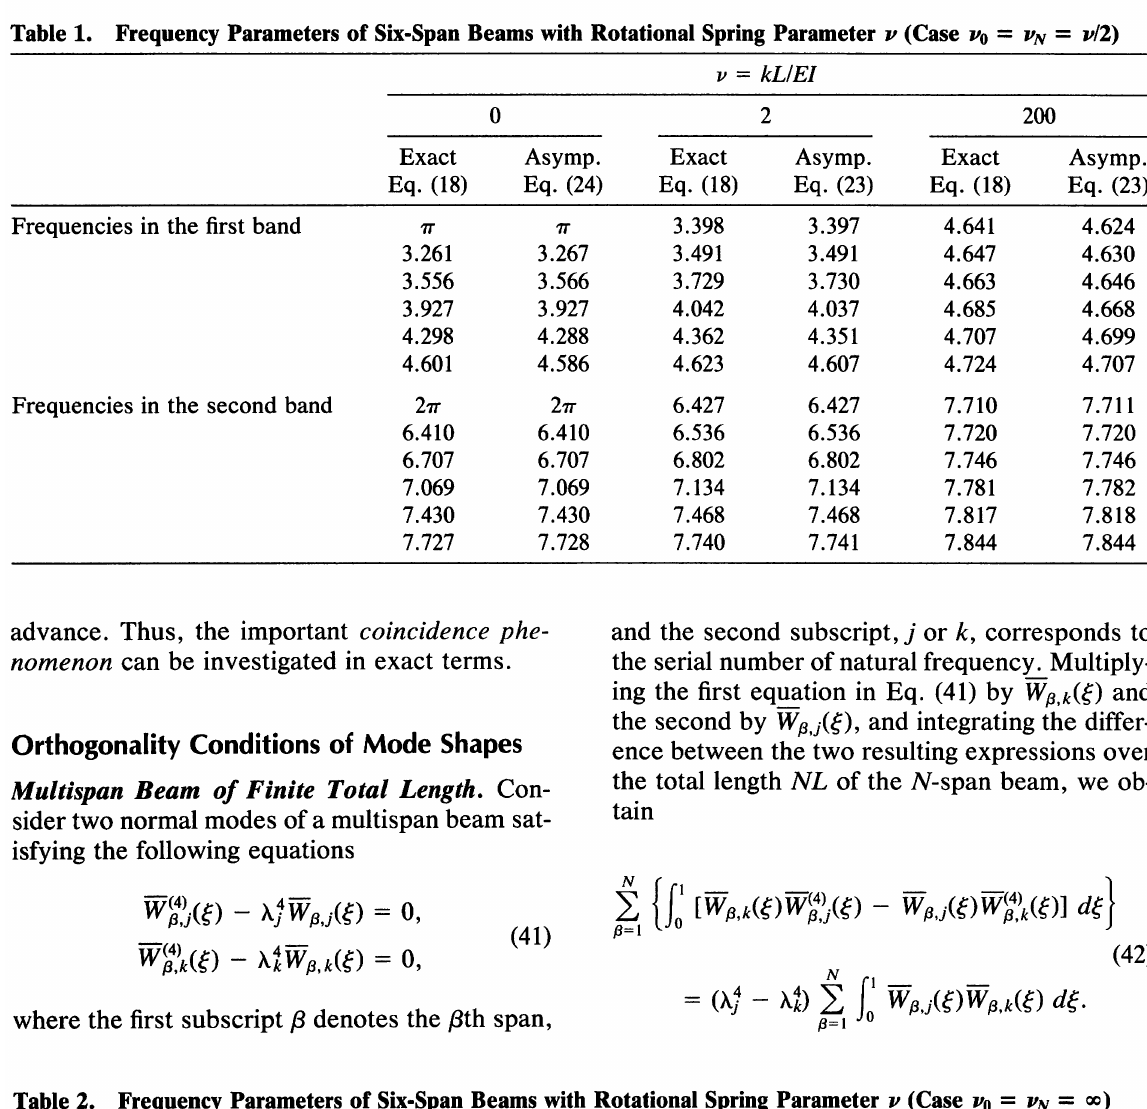
= = 00) VN II = kLlEI 0 2 200 Exact Asymp. Exact Asymp. Exact